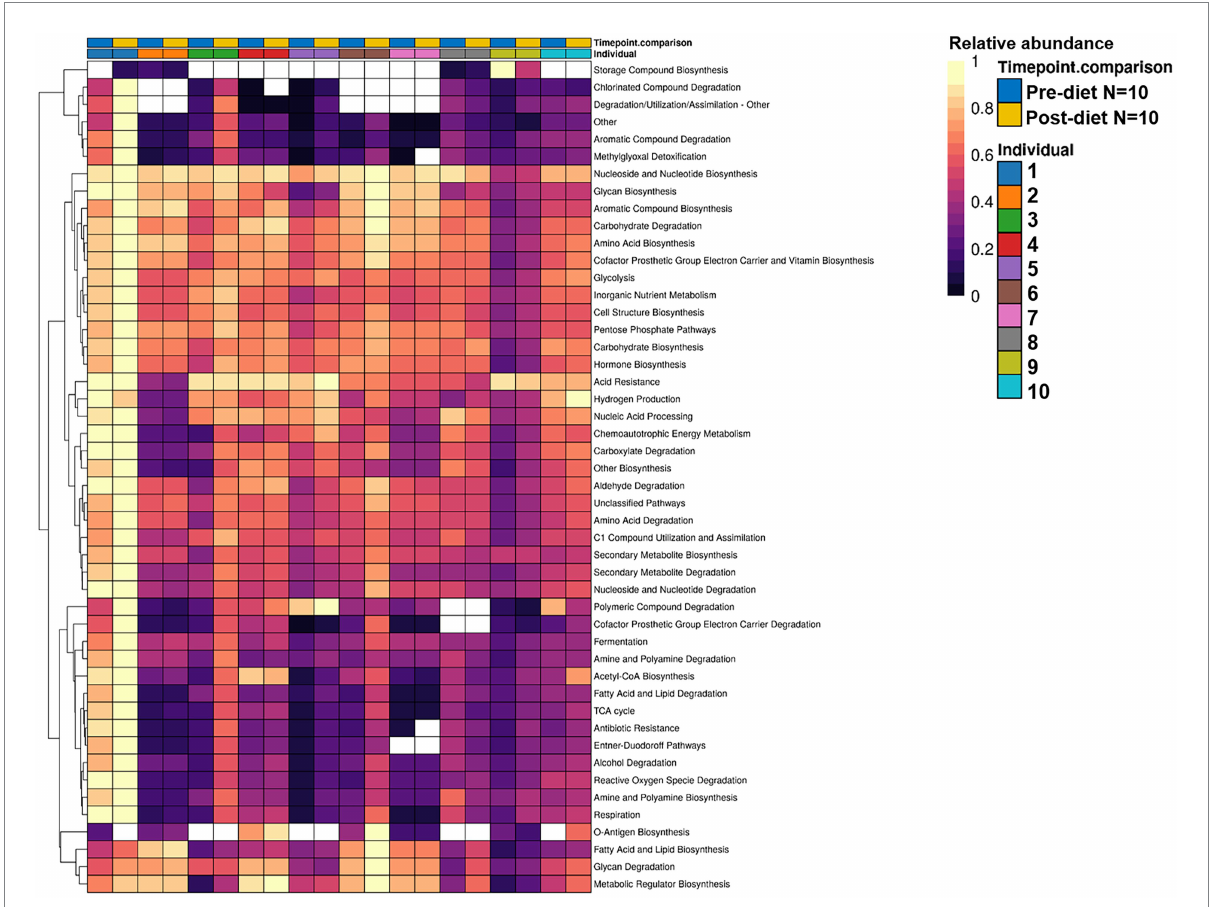
FIGURE 6 Hierarchically clustered heatmap showing the differential relative abundance of bacterial functional metabolic pathways across pre-diet vs. post- diet infant stool samples. A significant increase in the relative abundances of genes involved in 28 bacterial metabolic pathways was detected in post-diet compared to pre-diet